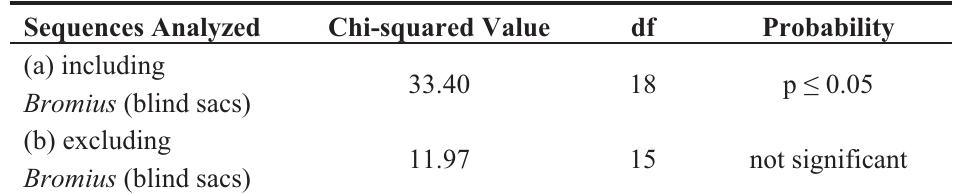
Table 3. Chi-squared test for homogeneity of nucleotide frequencies among the sequences obtained in the present